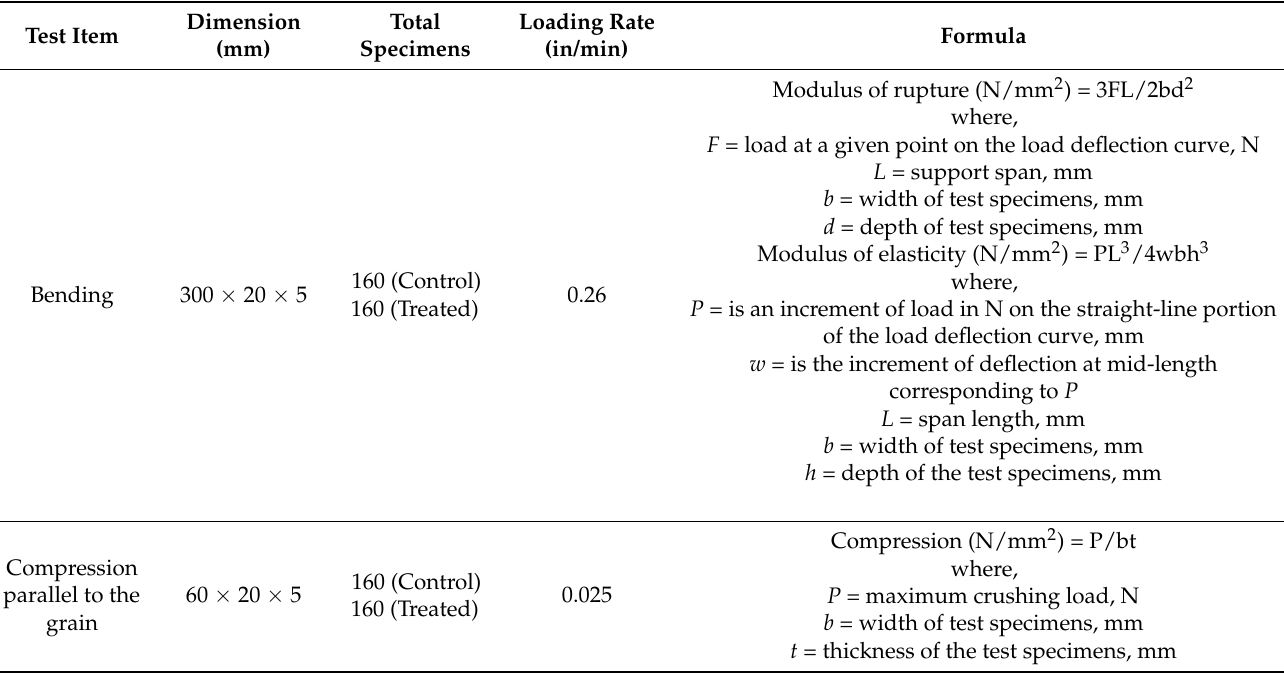
Table 2. Testing parameters of bamboo strips for the static bending and compression parallel to the grain